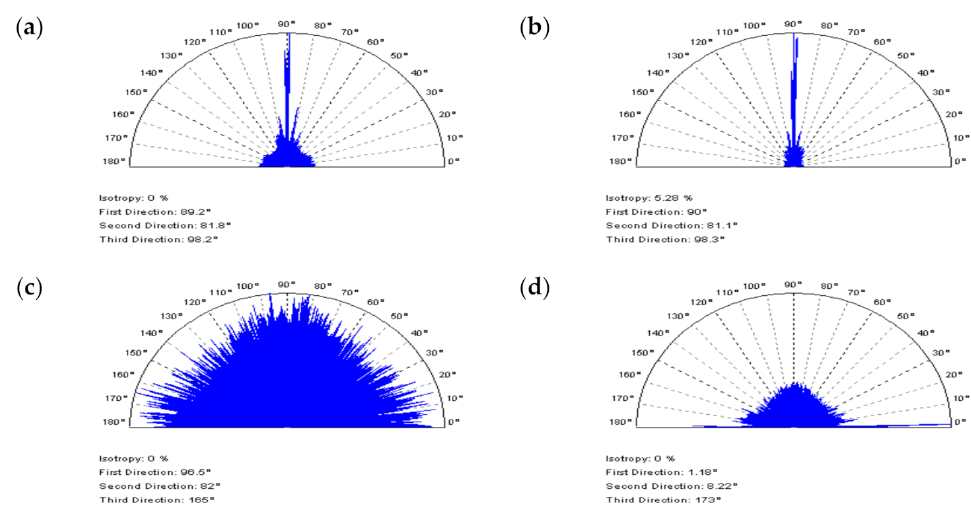
Figure 12. Texture direction graphs of NSs obtained for the laser liner textured surface after the application of ( a ) CSSF, ( b ) OPGF, ( c ) OPSF, and ( d ) CSOF.